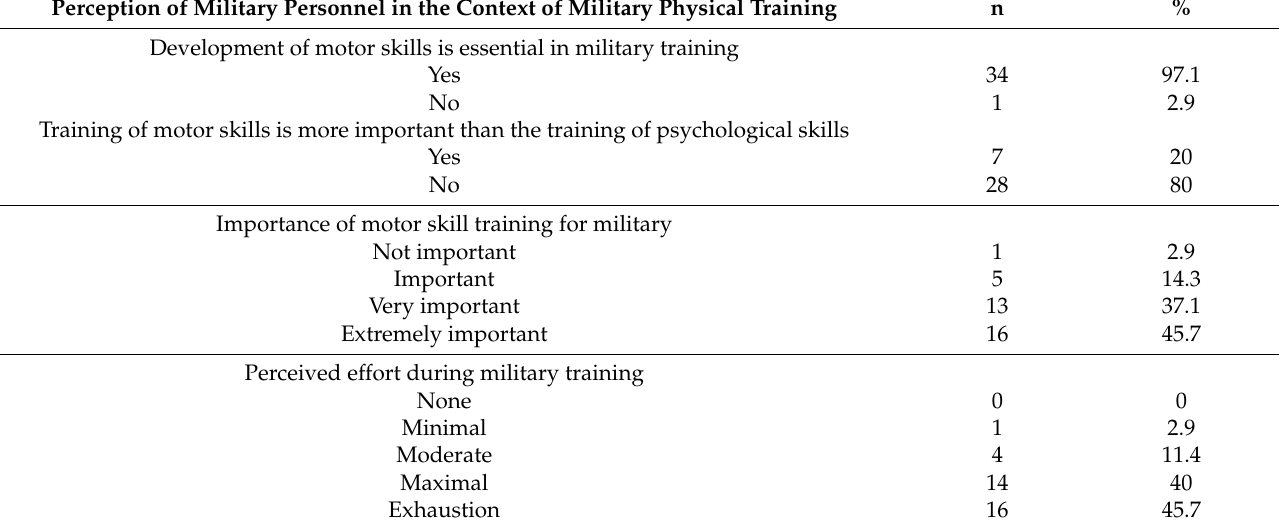
Table 2. Perception of motor skill training, physical effort and training of military personnel in the context of military physical